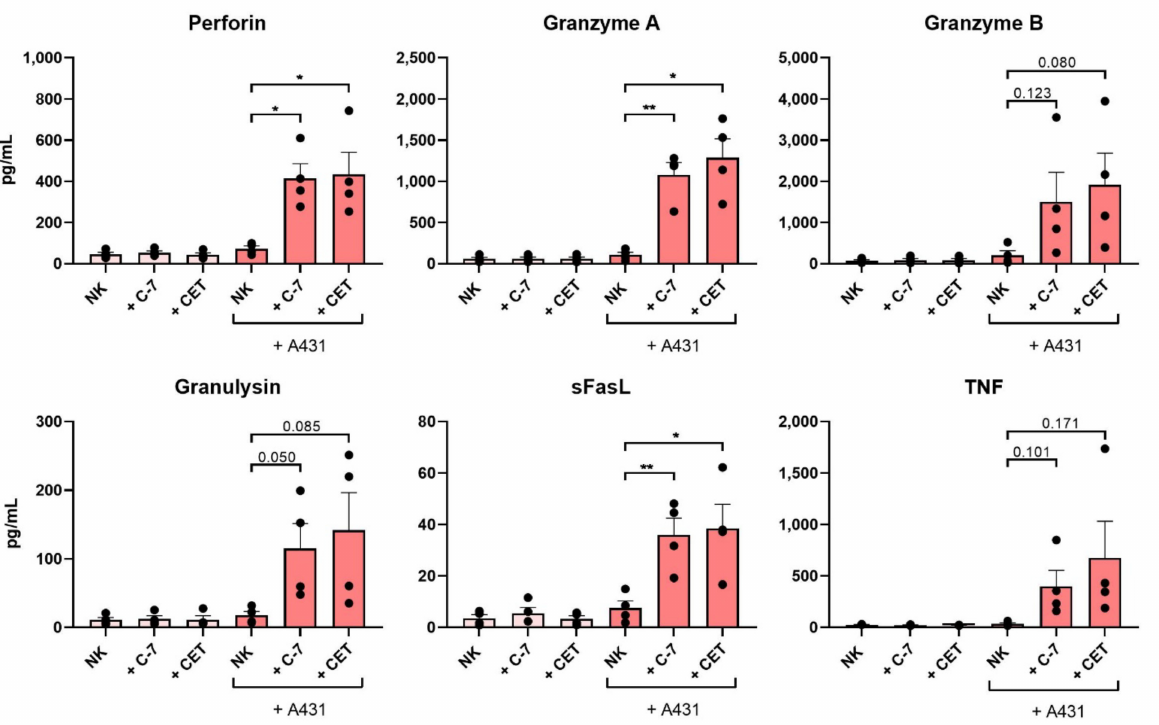
Figure 5. The C-7 bispecific VHH and cetuximab trigger NK cell secretion of pro-inflammatory and cytotoxic mediators. Cytometry Bead Array performed on supernatant of overnight-activated healthy donor-derived NK cells ± A431 ± 100 nM bispecific VHHs ± 5 µ g/mL cetuximab. E:T ratio 1:1. n = 4. The data are presented as mean ± SEM. Significance is indicated or presented as p < 0.05 *, <0.01 **. p -values are determined by two-tailed paired t-test. Abbreviations: C-7 = C21-7D12 bispecific VHH, CET =